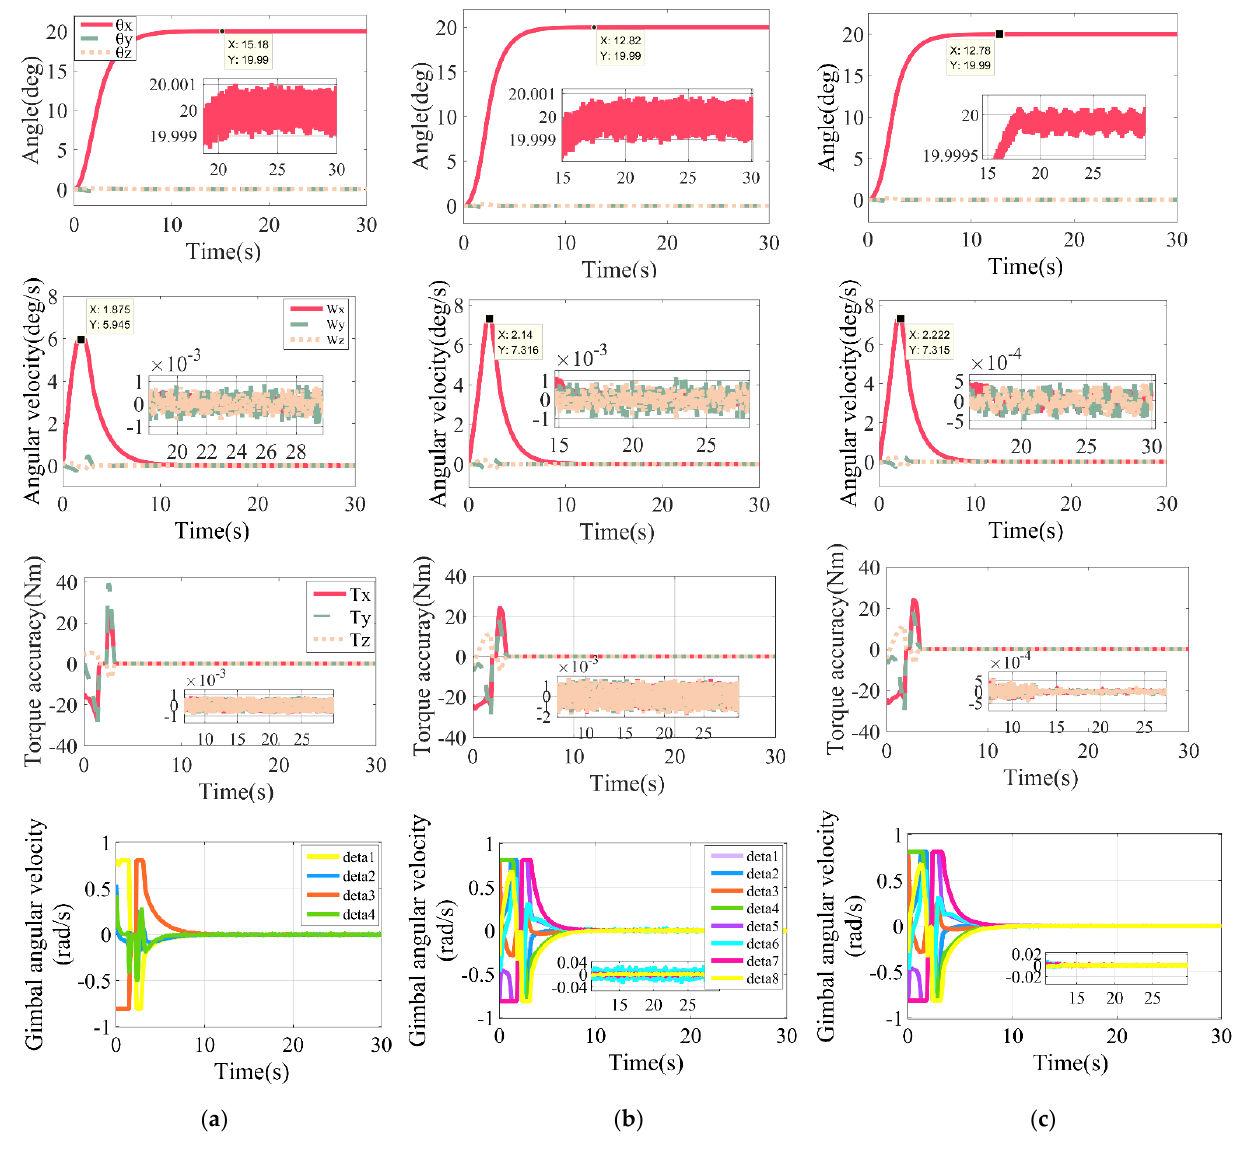
Figure 10. Simulation results of small−angle attitude maneuver. ( a ) Large 4−SGCMGs, ( b ) 8−SGCMGs, ( c ) Reconfiguration of 8−SGCMGs into 4−SGCMGs. Result 2 , Large−angle Attitude Maneuver (140deg) Table 9. Simulation results of attitude